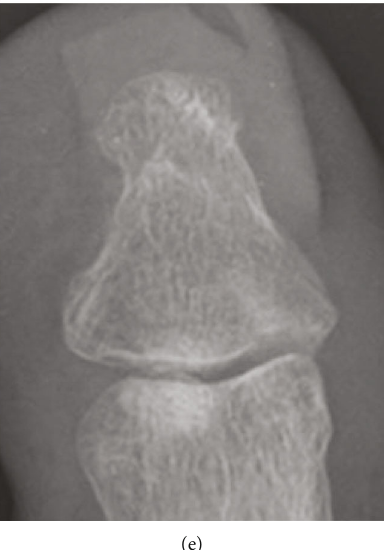
Figure 2: A case of symptomatic medial bone excrescence of the distal phalanx of the hallux after the metatarsophalangeal joint arthrodesis. Anteroposterior foot radiographs before surgery (a) and one year after surgery (b). Magni fi ed images showing obscure excrescence before surgery (c), de fi ned excrescence after arthrodesis (d), and disappeared excrescence after excision (e). Arrowheads indicate the bone